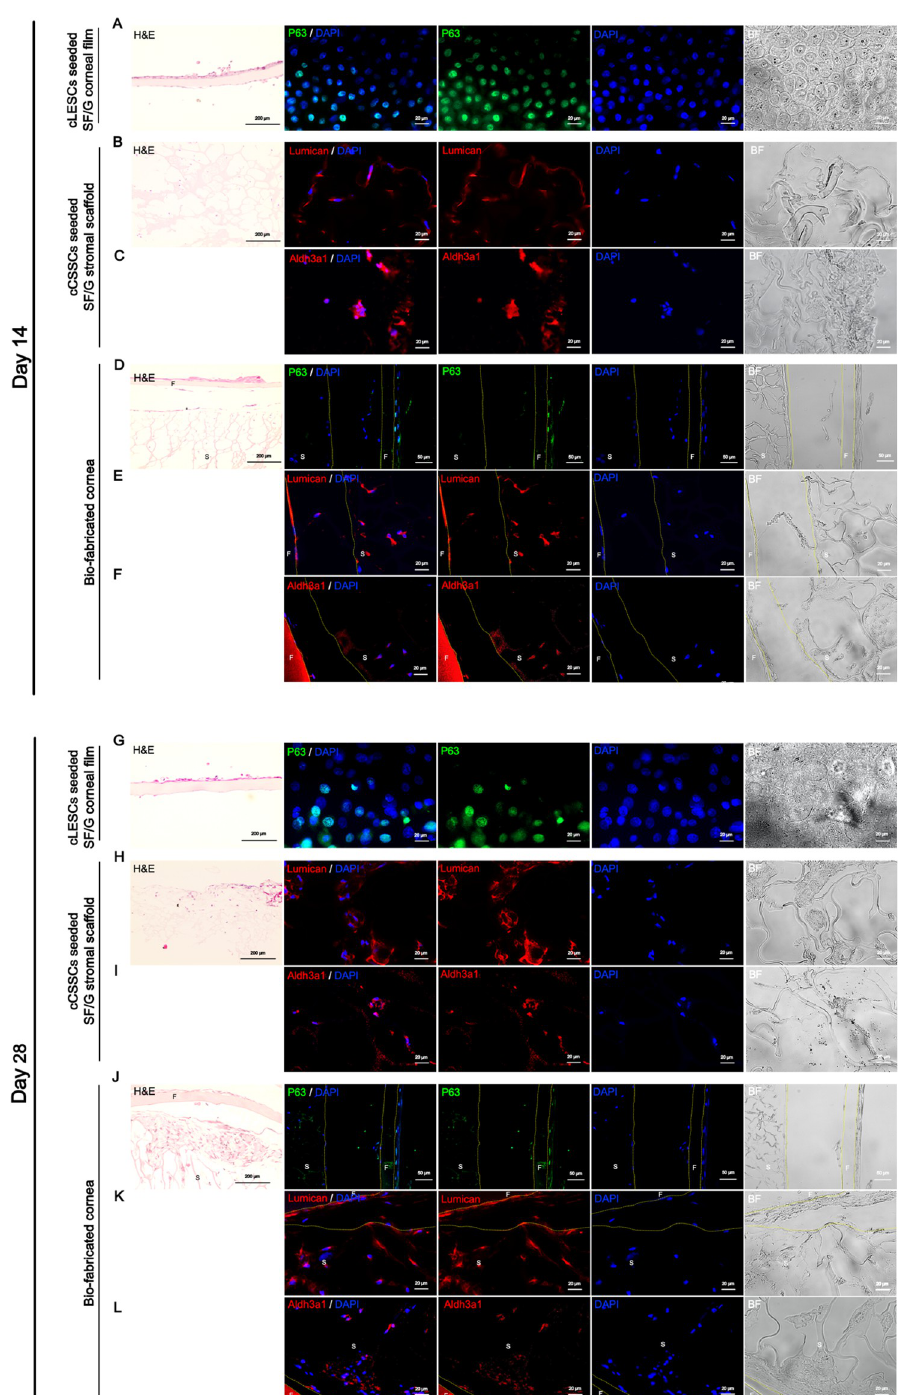
Fig 7. Morphology and immunocytochemical profiles. H&E staining shows 2–3 layers of cLESCs upon SF/G corneal film at day 14 (A) and day 28 (G) and the upper part of the bio-fabricated cornea at day 14 (D) and day 28 (J). cCSSCs were distributed over the SF/G stromal scaffold at day 14 (B) and day 28 (H) and the lower part of bio-fabricated cornea at day 14 (D) and day 28 (J). cLESCs seeded SF/G corneal film at day 14 (A) shows more P63-positive nuclear staining cells than day 28 (G). P63-positive nuclear staining cells are detected at the basal cells of the upper part of bio- fabricated cornea at day 14 (D) and day 28 (J). Lumican-positive cytoplasmic staining shows stronger intensity at day 28 for cCSSCs seeded SF/G stromal scaffold (H) and the lower part of bio-fabricated cornea (K) than day 14 of